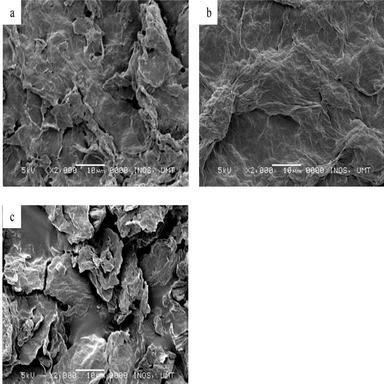
SEM image of (a) GO; (b) rGO; (c) PEDOT/rGO.